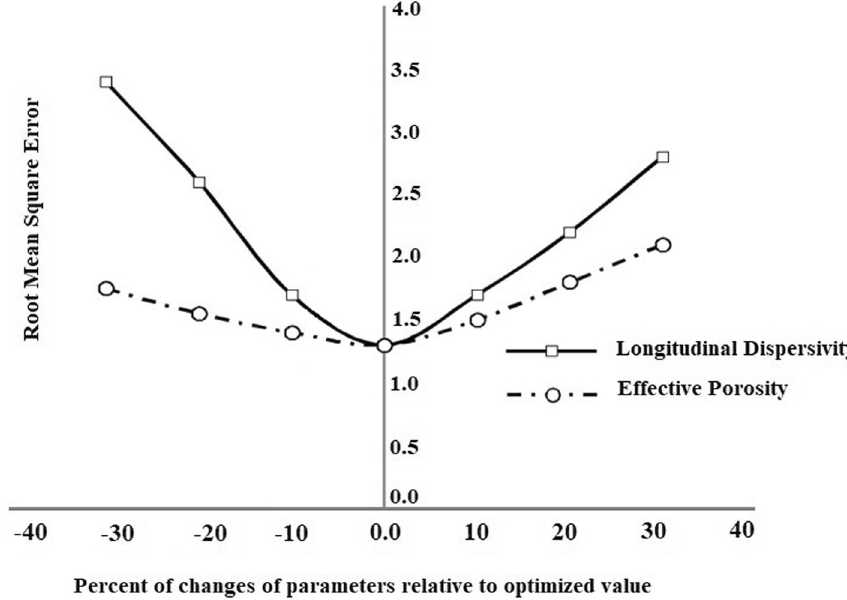
Fig. 10 Results of sensitivity analysis of the qualitative